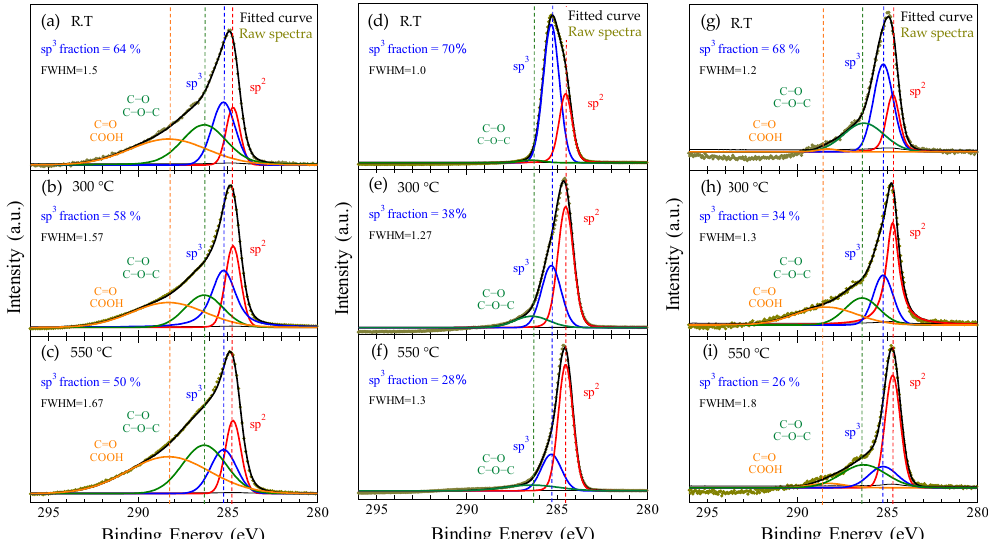
Figure 3. C 1s SXPES ( a – c ), and C 1s HAXPES ( d – f ), of Group I and C 1s SXPES ( g – i ), of Group II UNCD/a-C films deposited at substrate temperature of R.T. 300 °C and 550 °C.